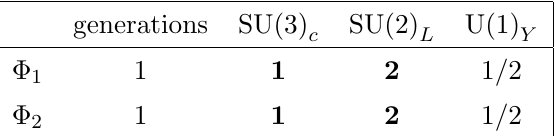
Table 3 . 2HDM scalar sector, composed of the two SU(2) generations